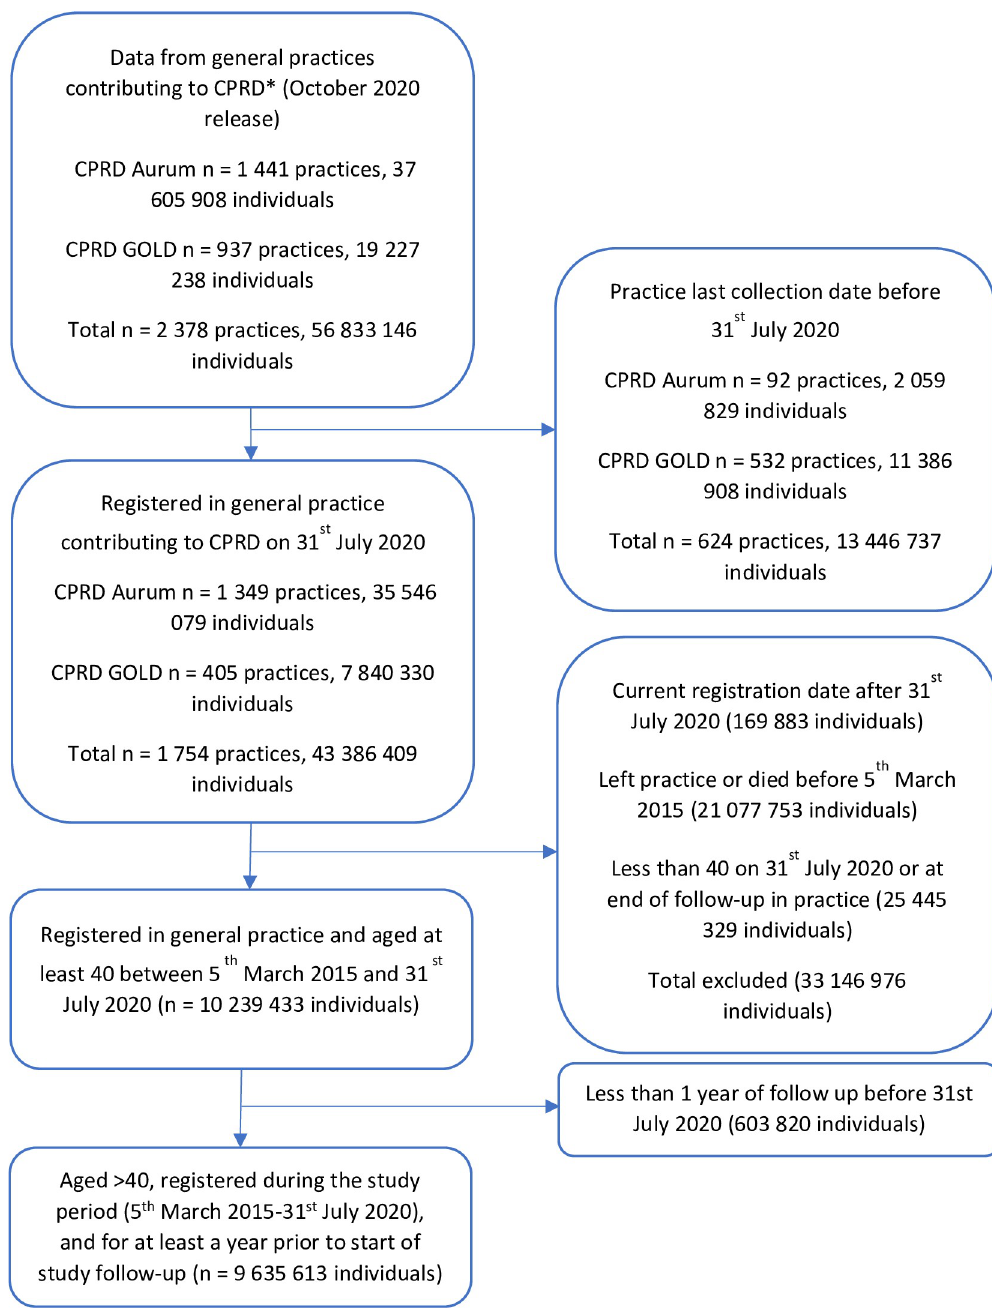
Fig 1. Study cohort selection for primary analysis. � Practices may contribute to both CPRD GOLD and CPRD Aurum over different time periods. Initial cohort restricted to patients who were permanently registered in the practice with valid registration data (termed “acceptable” by CPRD). CPRD, Clinical Practice Research